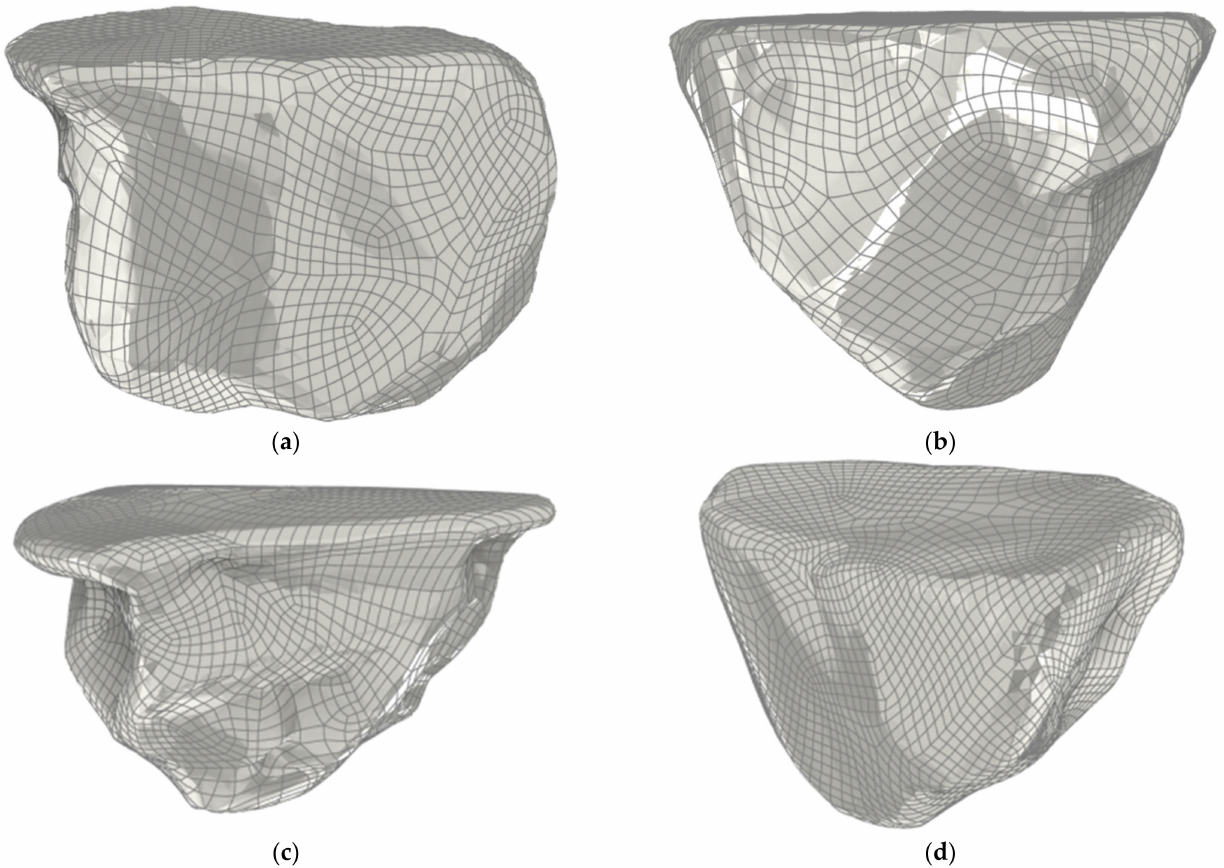
Figure 1. Alumina grains 97A with size F20, applied for numerical model validation ( a ) and numerical simulations ( b – d